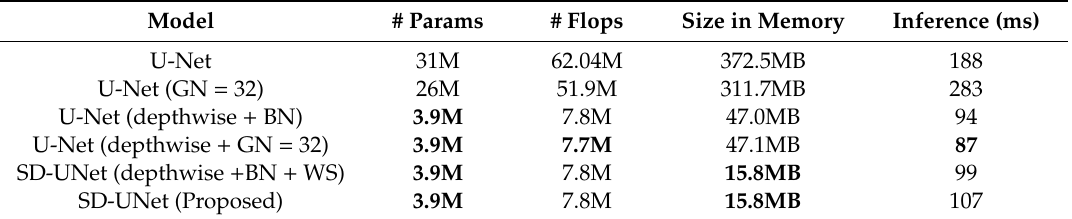
Table 1. Computational comparison of SD-UNet and other